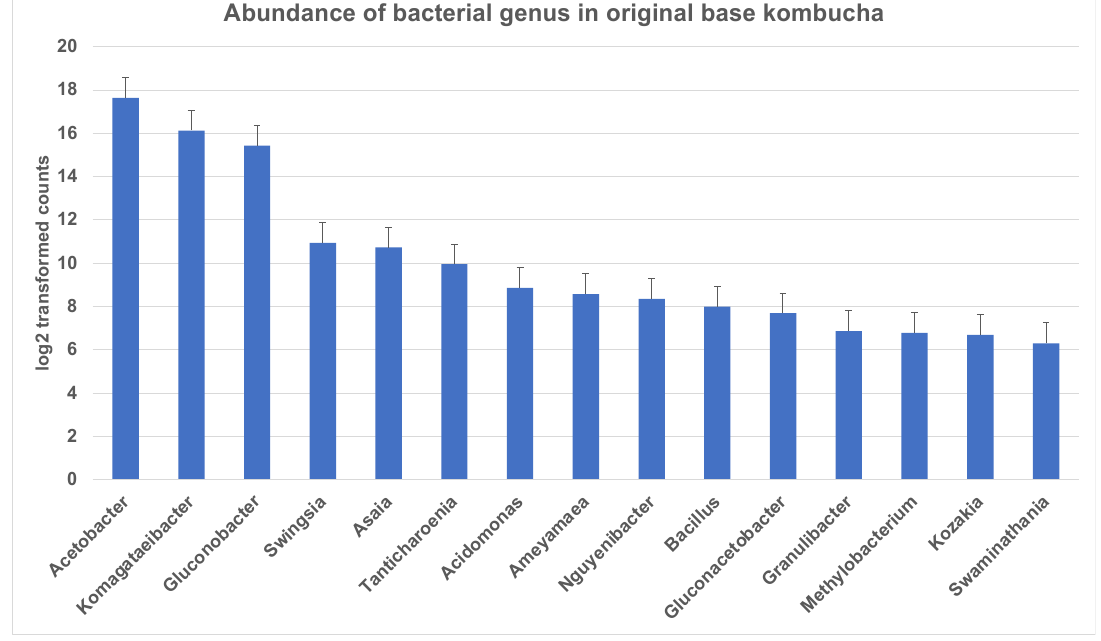
Figure 1 . Most abundant bacterial genus in original base kombucha. Acetobacter being the most dominant genus followed by Komagataeibacter and Gluconobacter . The error bars are standard error (SE) calculated across the triplicate values of samples.